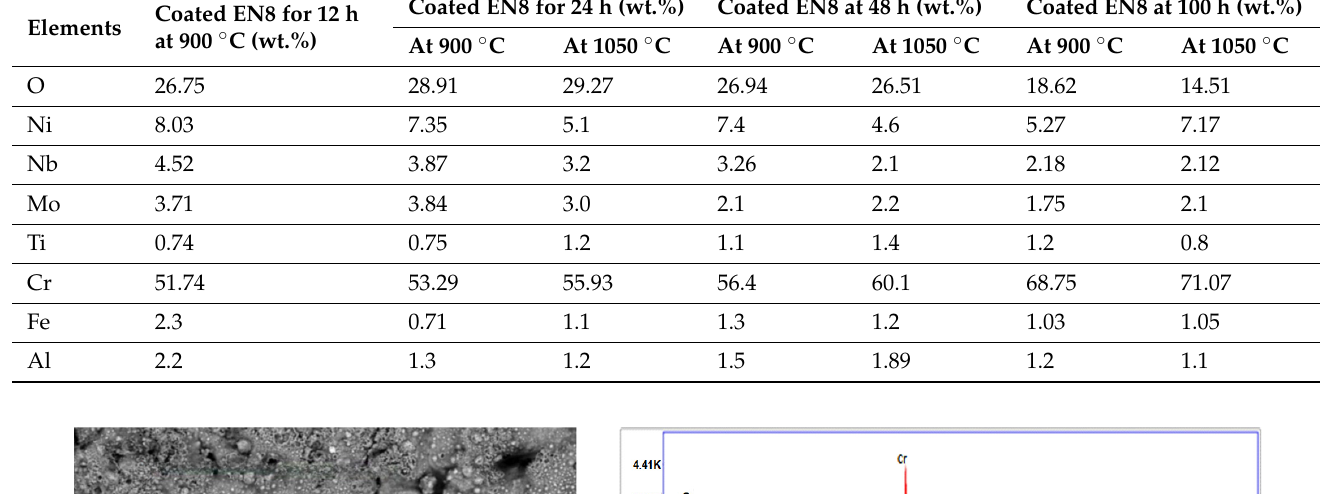
Table 4. EDS Composition of coated EN8 for different oxidation times and at different temperatures.